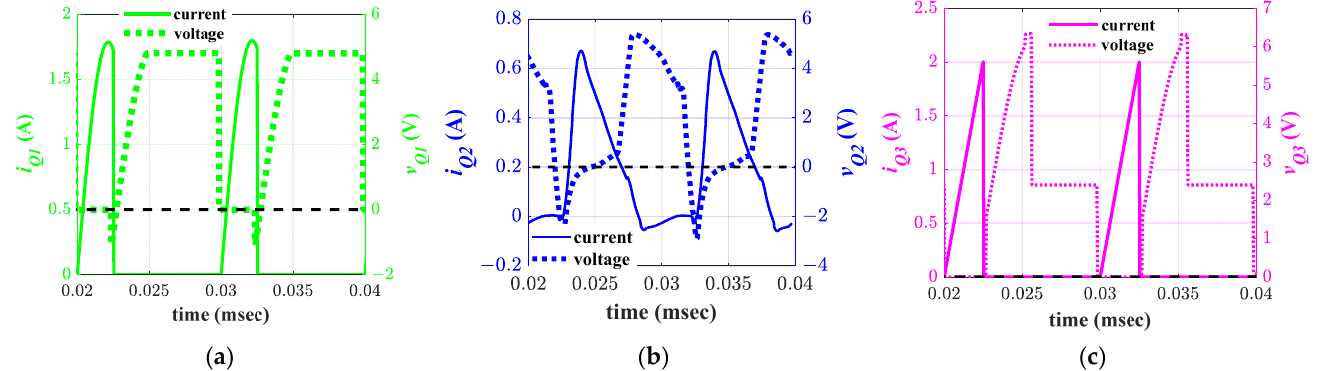
Figure 13. The simulation results showing the soft switching of the switches in the test conditions ( D = 0.2 and d = 0.45). ( a ) Q1 voltage and current; ( b ) Q2 voltage and current; ( c ) Q3 voltage and current.